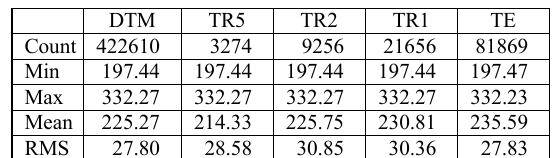
Table 1. Statistics of the sampled datasets. Values in m.